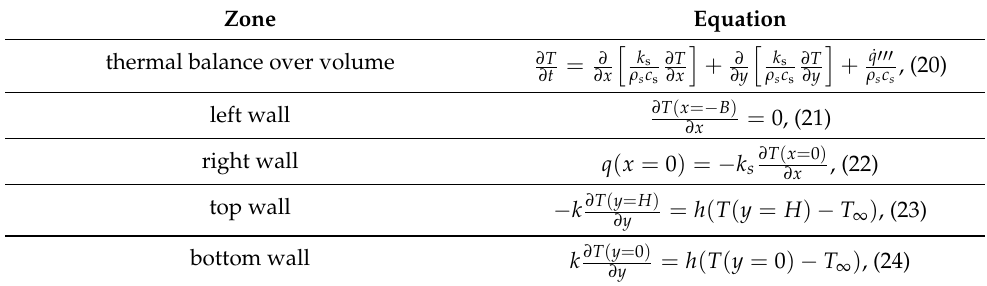
Table 6. Governing equations and thermal boundary conditions for heat transfer in solid part